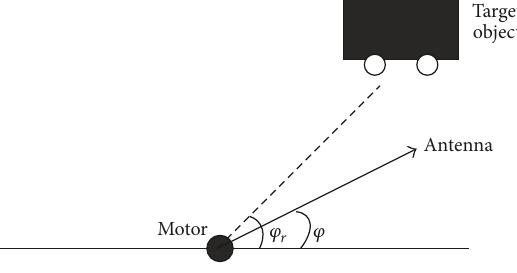
Figure 4: The angular positioning system.